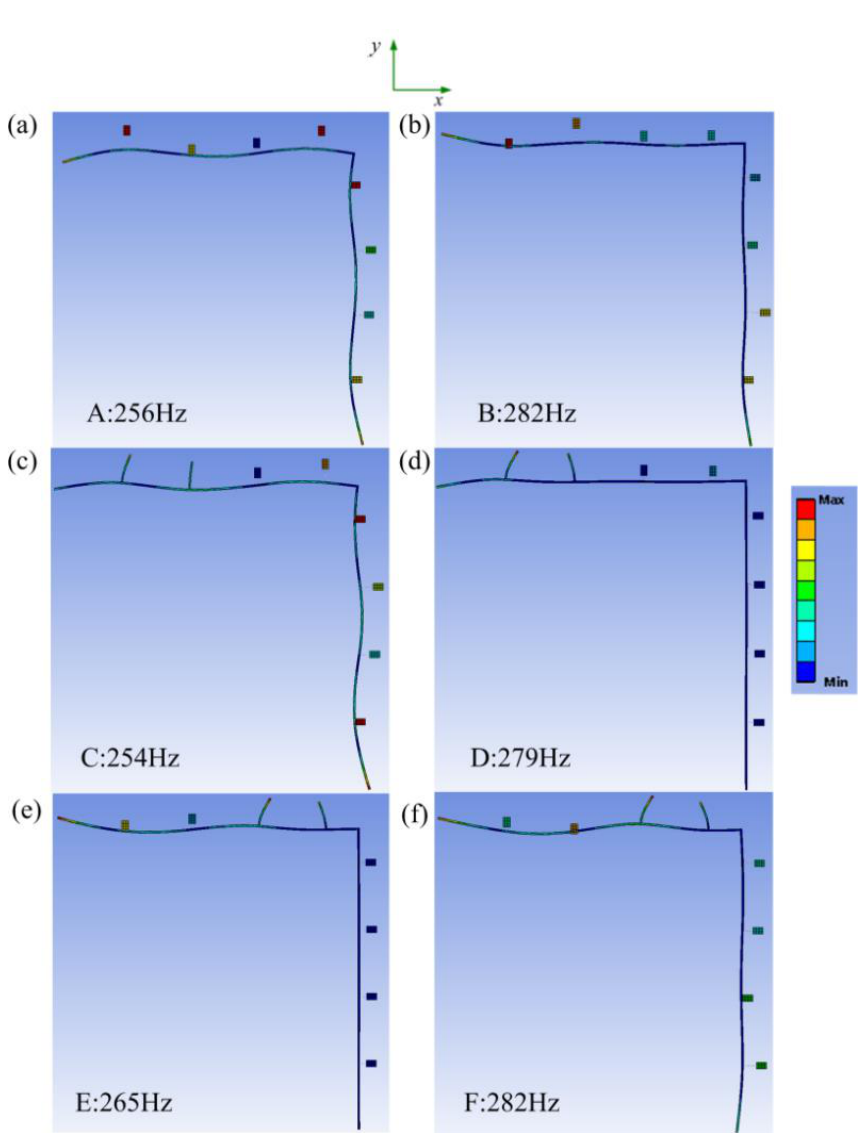
Figure 14. The analysis of steady-state vibration deformations of ( a ) point A; ( b ) point B; ( c ) point C; ( d ) point D; ( e ) point E; ( f ) point F.